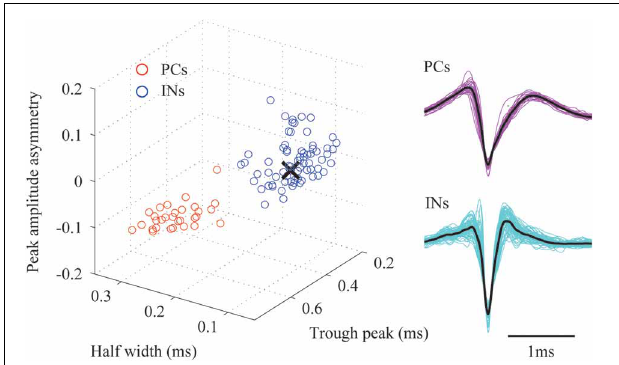
FIGURE 2 | A classification of the detected spikes. The right panel shows the classified mean spike waveforms of the excitatory pyramidal cells (PCs) and interneurons (INs). Black lines denote their mean spike waveforms. Left panel shows the spike waveforms as projected onto the three-dimensional feature space. The black cross indicates the mean spike waveform of the detected spiny stellate (SS)